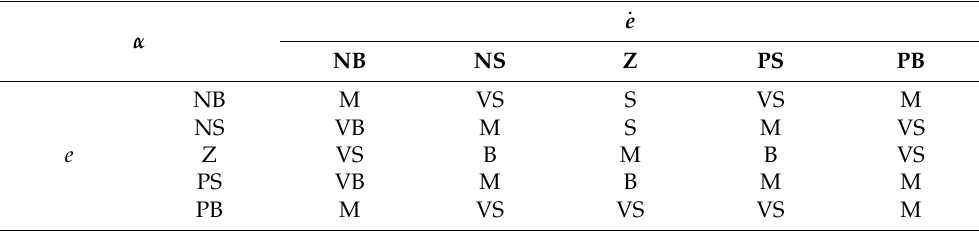
Table 2. Fuzzy tuned rules for α .